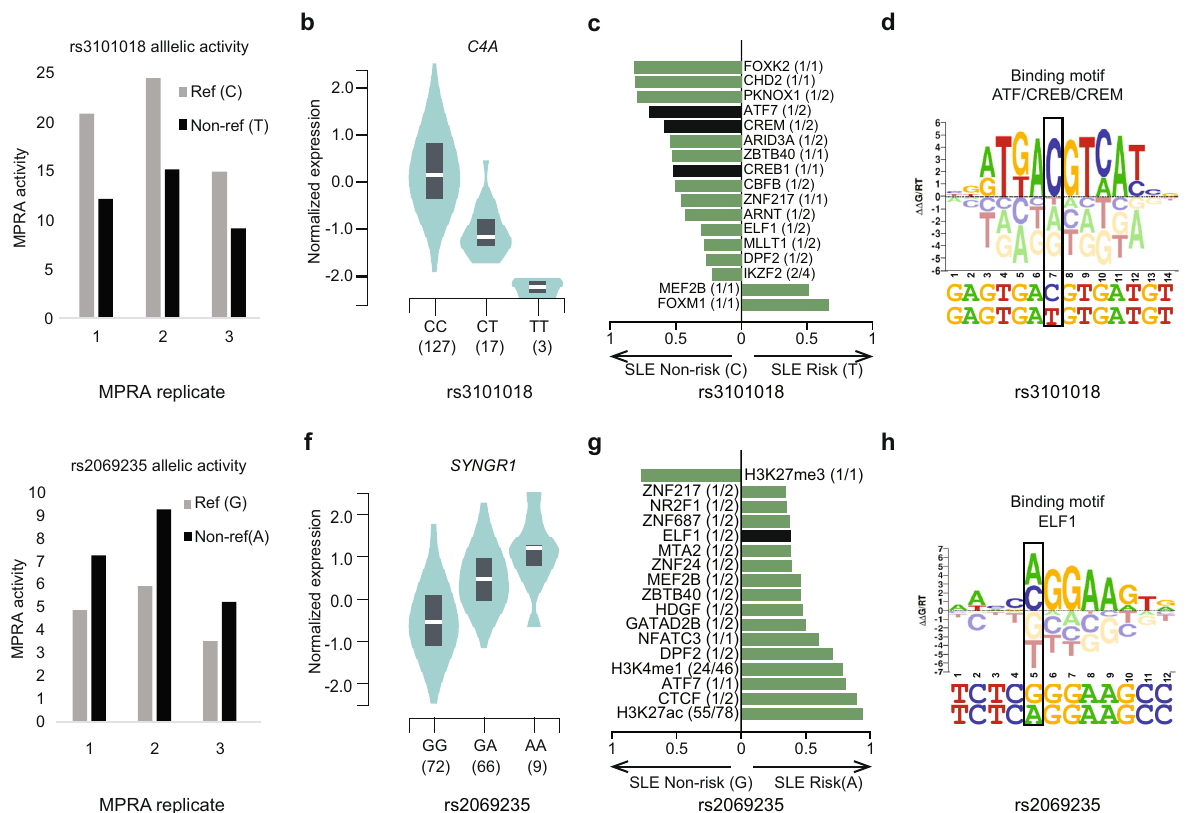
Fig. 4 Lupus risk allele-dependent gene regulatory mechanisms at the C4A and SYNGR1 genomic loci. a , e Normalized MPRA enhancer activity of each experimental replicate for rs3101018 and rs26069235. b , f Expression trait quantitative loci (eQTLs) revealing genotype-dependent expression of C4A and SNYGR1 for rs3101018 (CC, n = 127 biologically independent samples; CT, n = 17; TT, n = 3) and rs26069235 (GG, n = 72 biologically independent samples; GA, n = 66; AA, n = 9) in EBV-transformed B cell lines (GTEx). c , g Genotype-dependent activity of transcription factors, transcriptional regulators, and histone marks in EBV-transformed B cell lines for rs3101018 and rs26069235. Results with MARIO ARS value >0.4 and consistent allelic imbalance across ChIP-seq datasets are included (see “ Methods ” ). The X -axis indicates the preferred allele, along with a value indicating the strength of the allelic behavior, calculated as one minus the ratio of the weak to strong read counts (e.g., 0.5 indicates the strong allele has twice the reads of the weak allele). The median value is plotted when data from multiple cell lines are available, with full results provided in Supplementary Fig. 4. The numbers in parentheses represent the number of ChIP-seq datasets with signi fi cant allelic activity (i.e., MARIO ARS value >0.4) out of the number of datasets where the given variant is inside a ChIP-seq peak and is also heterozygous in the given cell line. Variant overlapping TFs are indicated in black. Variant adjacent TFs are shown in green (see de fi nition in Fig. 5a). d , h DNA-binding motif logos are shown for the ATF/CREB/CREM family, and ELF1 in the context of the DNA sequence surrounding rs3101018 and rs2069235, respectively. Tall nucleotides above the X -axis indicate preferred DNA bases. Bases below the X - axis are disfavored. In ( b ) and ( f ), data are represented as a violin plot where the middle line is the median, the lower and upper hinges correspond to the fi rst and third quartiles, with the rotated kernel density plot shown on each side. The data used for the analyses were obtained from the Genotype-Tissue Expression (GTEx) Portal on 11/12/2020. The GTEx Project was supported by the Common Fund of the Of fi ce of the Director of the National Institutes of Health, and by NCI, NHGRI, NHLBI, NIDA, NIMH, and NINDS. in SLE 2 . We identi fi ed 92 SLE-risk variants as allelic enVars in (Fig. 5b). Consistent with our results at the C4A and SYNGR1 loci, variant overlapping TFs include members of the ETS (e.g., Jurkat cells, 25% of which were also found in GM12878 (Sup- ELF1) and ATF-like (e.g., ATF7) families, along with other TFs plementary Fig. 5a, b and Supplementary Data 11). We then whose genetic loci are associated with SLE, including IRF5 44 repeated the experiment in Jurkat cells stimulated with the in fl ammatory cytokine TNF α , a key cytokine in SLE develop- (Fig. 5c and Supplementary Data 15). Variant adjacent TFs ment 48 , to identify stimulation-dependent allelic enVars. This represent a distinct class, but also include several TFs with SLE resulted in the identi fi cation of 102 allelic enVars, 28 of which genetic associations, including NF κ B 45 , the Ikaros (IKZF) family 46 , and HMGA family members 47 (Fig. 5d and Supple- were speci fi c to the stimulated Jurkat cells (Supplementary Fig. 5c, d and Supplementary Data 11). Altogether, our study identi fi ed a total of 145 allelic enVars across 50 independent SLE- risk loci (Supplementary Fig. 5e). These results highlight allelic transcriptional regulatory mechanisms that are both cell-type and in fl ammatory signaling-dependent. In summary, through the application of an allelic MPRA library to the EBV-transformed B cell line GM12878, we identi fi ed global transcriptional enhancer activity at 16% of SLE-associated genetic variants (enVars), with particular NATURE COMMUNICATIONS| (2021) 12:1611